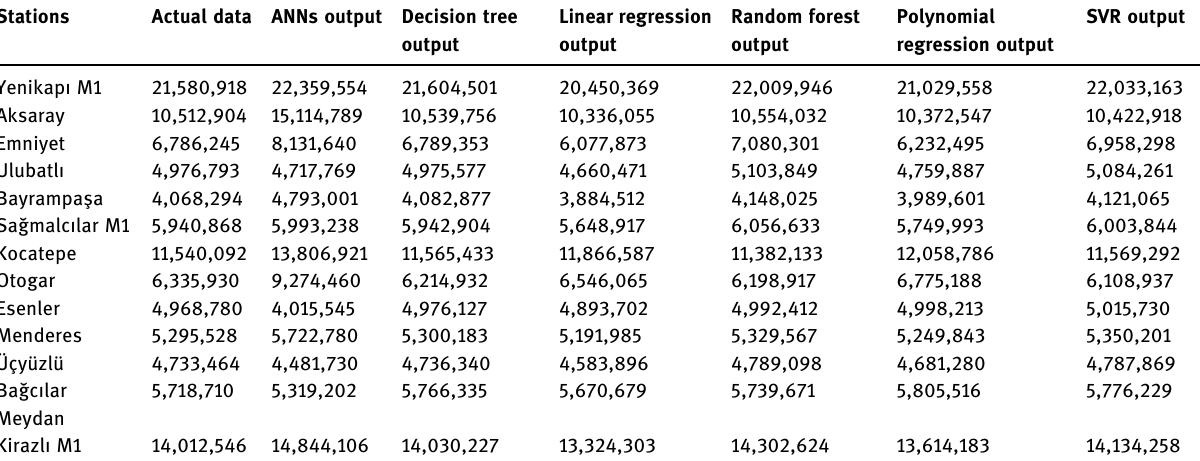
Table 10: The actual value and station based forecast values